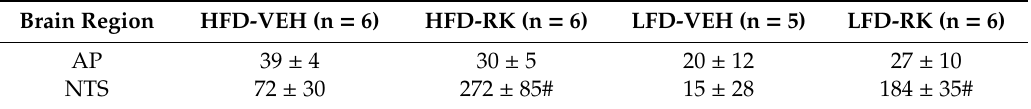
Table 1. Average immunoreactive c-Fos counts in the area postrema (AP) and nucleus of the solitary tract (NTS) from mice orally dosed with vehicle or raspberry ketone (400 mg/kg). Mice were fed high-fat diet (HFD; 45% fat) or low-fat diet (LFD: 10% fat) and orally dosed vehicle (VEH) or raspberry ketone (400 mg/kg) for 14 days. Mice were euthanized on day 14, 120 min after respective dosing. Immunopositive cell counts are means ± SEM.